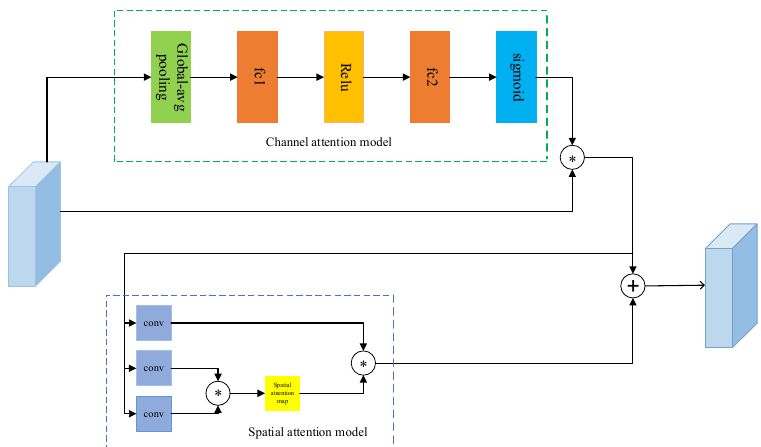
Figure 3. Dual-attention Module.